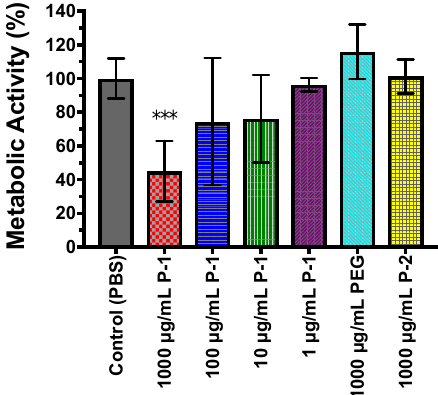
Figure 9. Metabolic activity assessed by MTT assay dependence on polymer concentration after 24 hours of incubation in the presence of P-1, PEG, or P-2. PBS was used as a positive control. The experiment was performed in duplicate, and the absorbance was determined as the average of data for each experiment. The data points and error bars represent the average and s.d from data in three independent experiments ( n = 3), with significance (*** p ≤ 0.001) indicated against control (PBS).